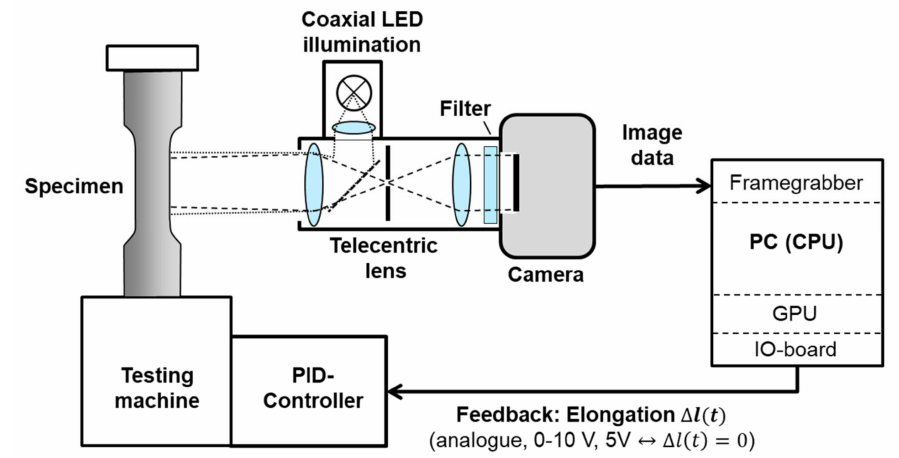
Figure 1. Functional diagram of the closed-loop system. The digital image correlation (DIC) system delivers an analogue elongation signal so that it directly replaces a mechanical